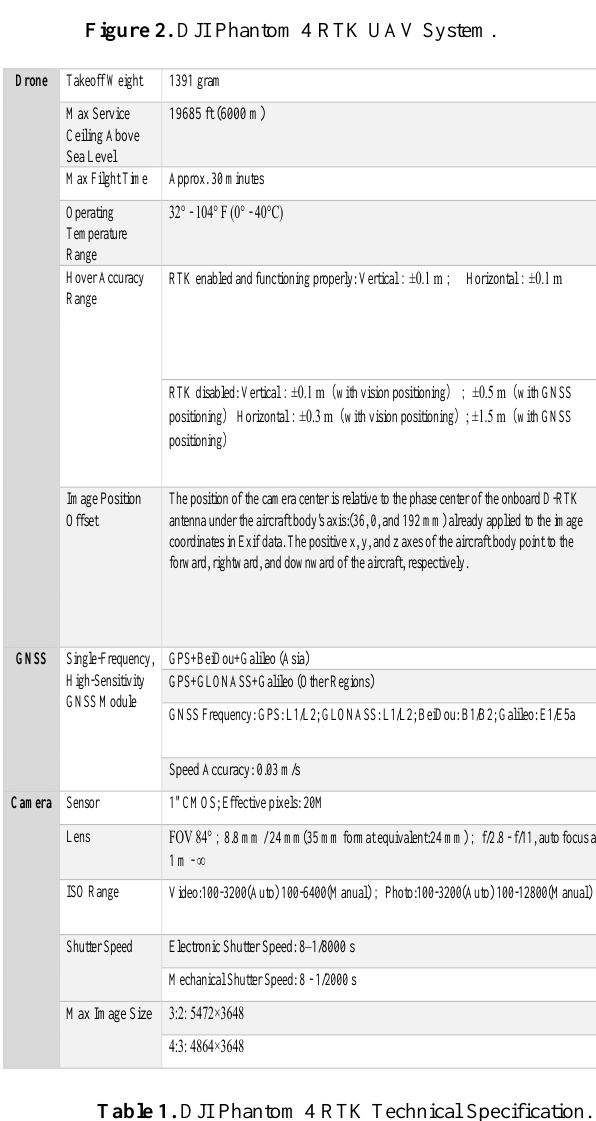
Table 1. DJI Phantom 4 RTK Technical